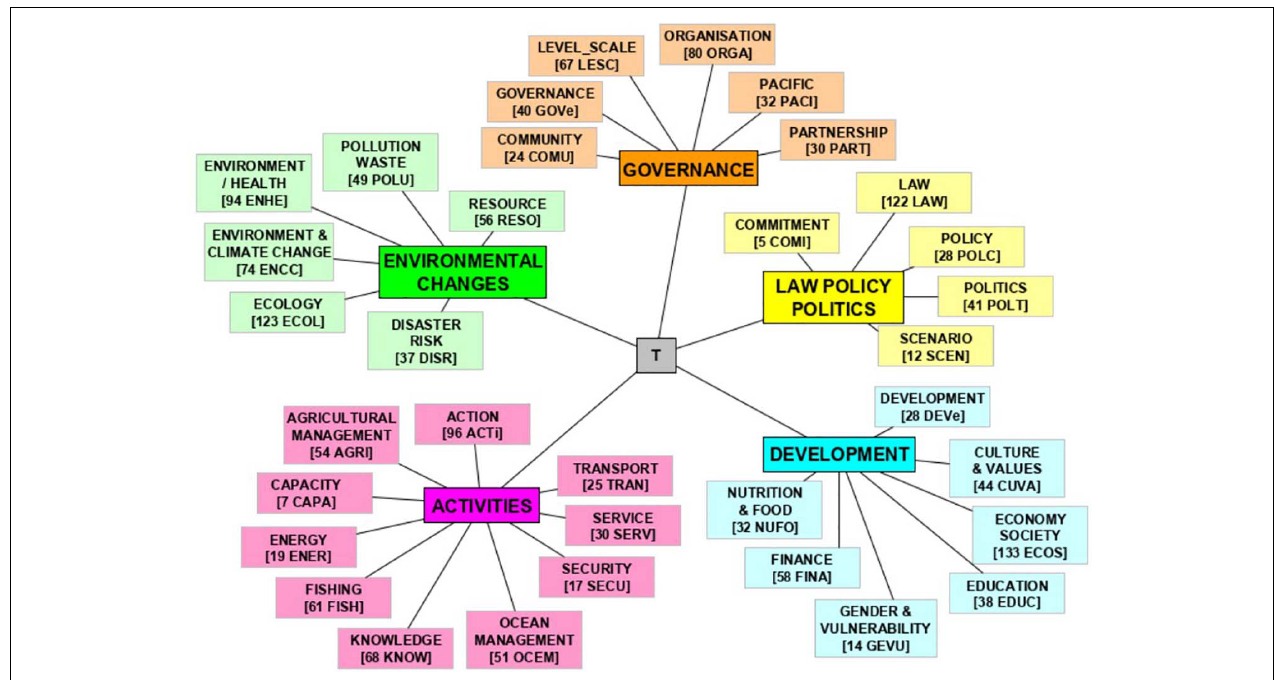
FIGURE 1 | Taxonomy built from the vocabulary of significant autonomous expressions extracted from the policy corpus. The total field of the taxonomy is partitioned in five domains – Activities , Development , Environmental Changes , Governance , and Law Policy Politics . Each domain is partitioned into themes which number of related lemmas (see text) and label are given into brackets (see the Annex for